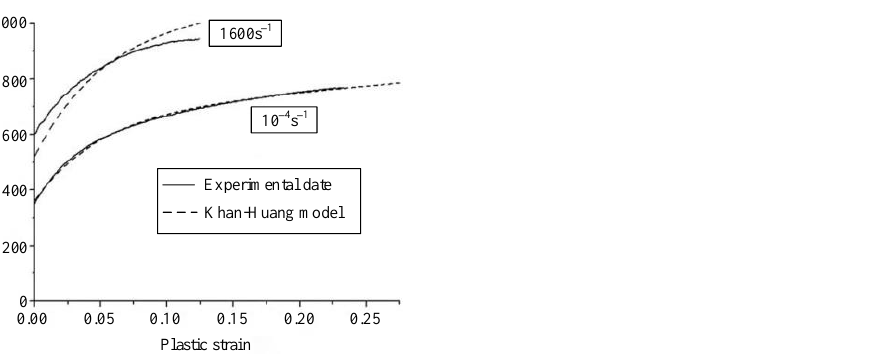
. p ε represents the current strain rate, . . p p ε ε / is shown in Figure 5. 0